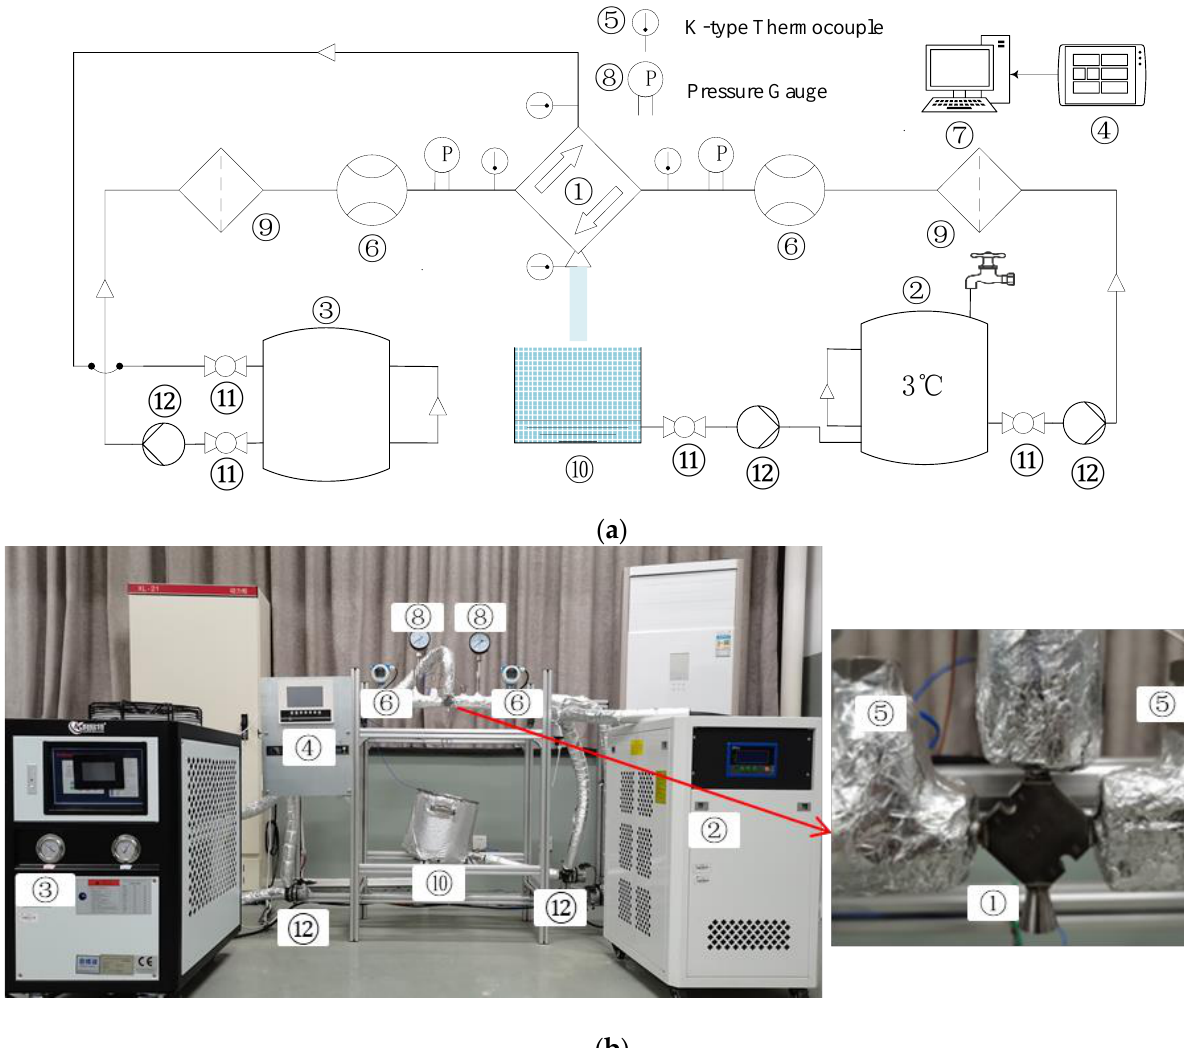
Figure 2. Subcooled water generation setup. ( a ) Schematic of subcooled water generation setup. ( b ) Photo of subcooled water generation setup. 1 (cid:13) Compact heat exchanger. 2 (cid:13) (High-temperature) thermostatic device. 3 (cid:13) (Low-temperature) thermostatic device. 4 (cid:13) Computer. 5 (cid:13) K-type thermo- couple. 6 (cid:13) Turbine flowmeter. 7 (cid:13) Data recorder. 8 (cid:13) Pressure gauge. 9 (cid:13) Filter. 10 (cid:13) Ice storage tank. 11 (cid:13) Ball valve. 12 (cid:13) Water